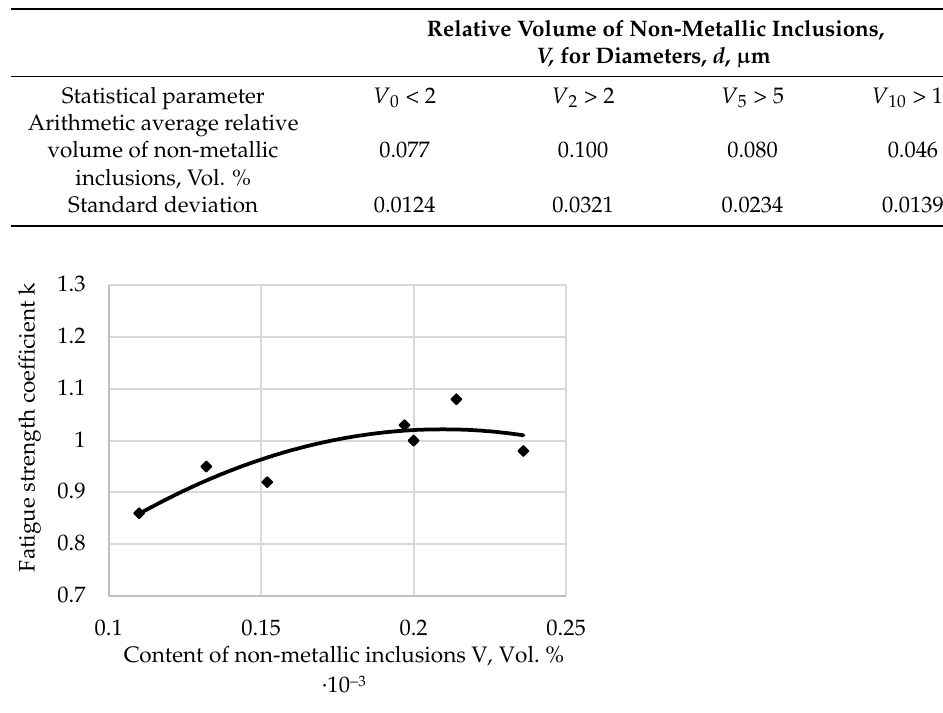
Figure 3. The bending fatigue strength coefficient, k , of research steel after hardening and tempering at 300 °C depends on the relative content of non-metallic inclusions.